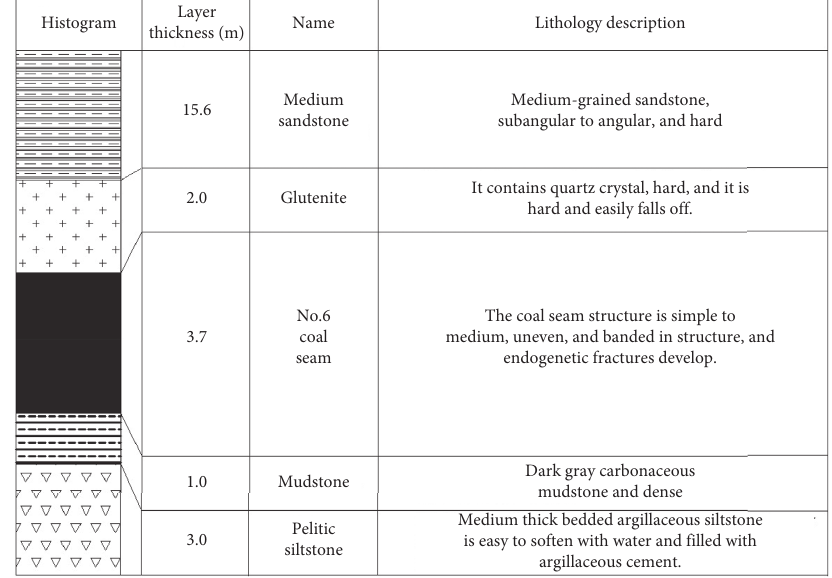
Figure 2: Comprehensive stratigraphic chart for No. 6 coal seam. Table 1: Mechanical parameters of the